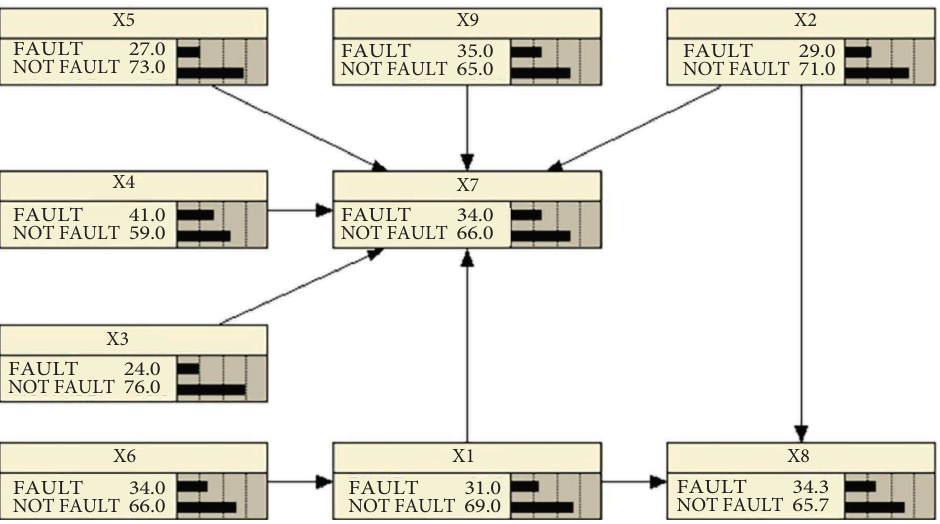
Figure 14: Bayesian network of CSTR